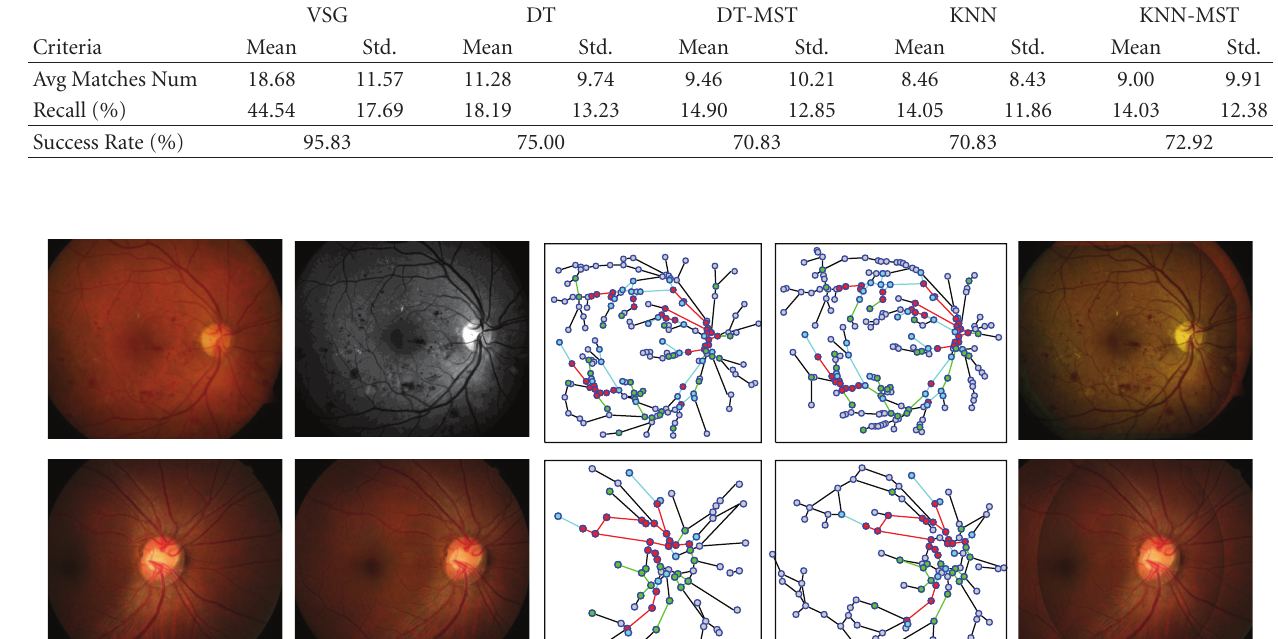
Table 1: The comparative experiment results of five topological graphs for graph matching.